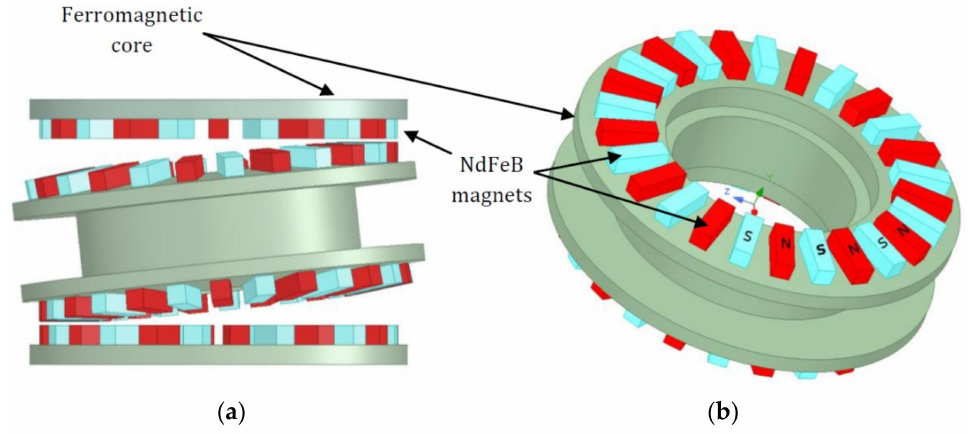
Figure 4. Concept of a magnetic precession gear: ( a ) general view of magnetically active components and ( b ) structure of the intermediate ring with marked directions of magnetization of the